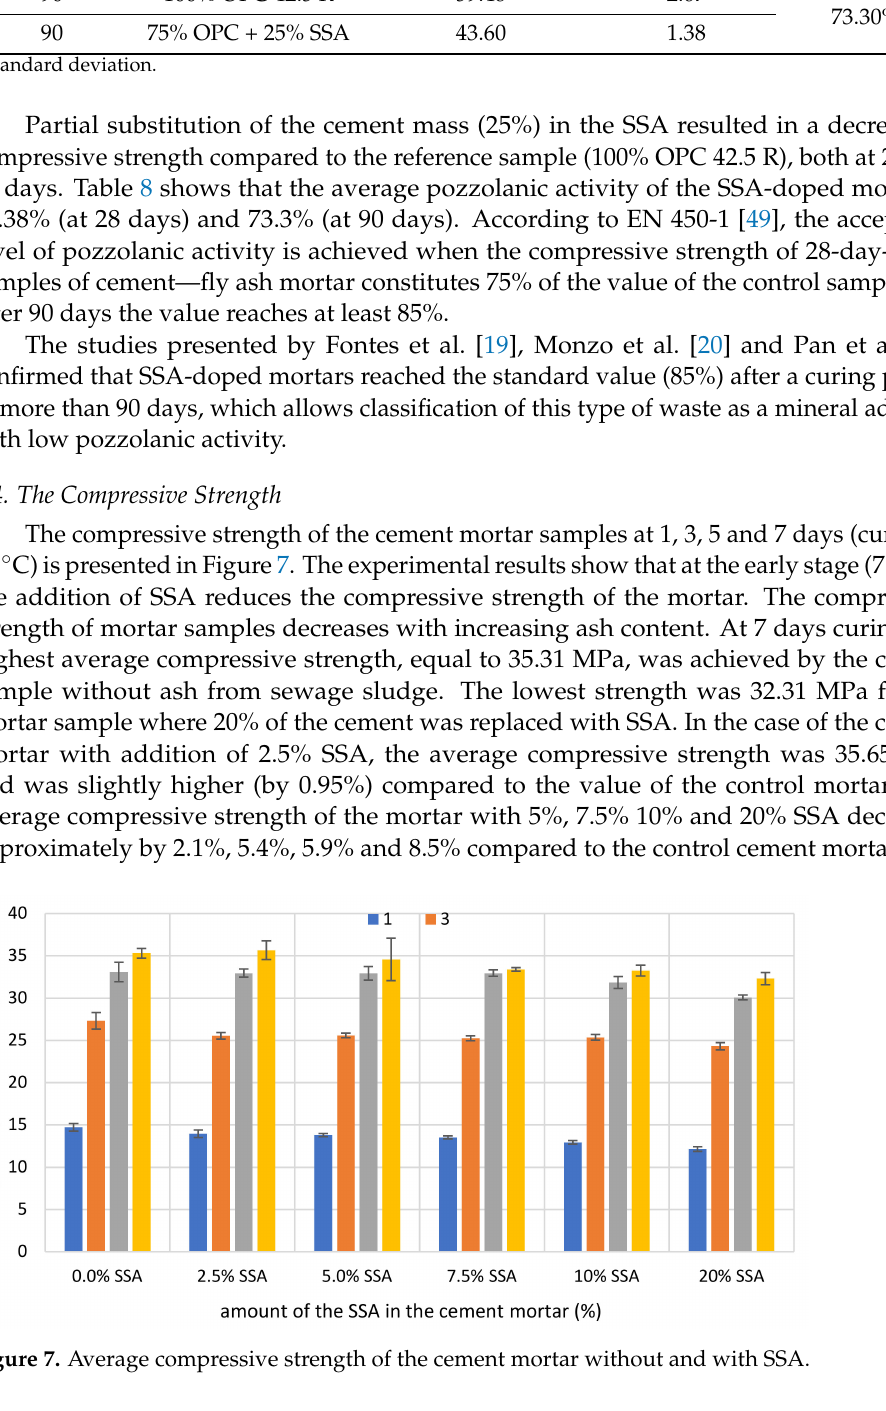
Days Mortar Type